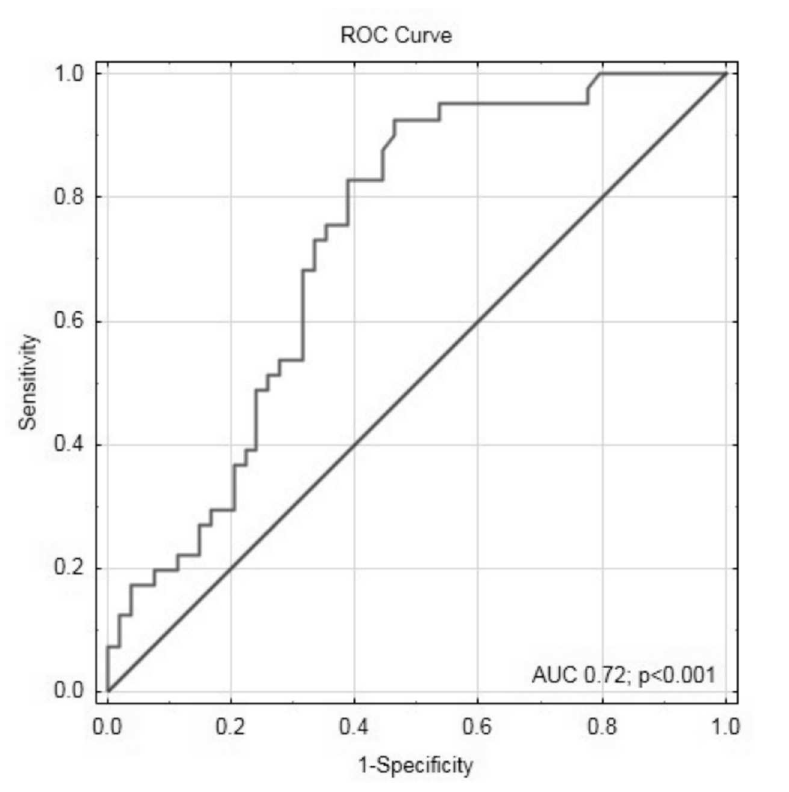
Figure 2. ROC curve (validation